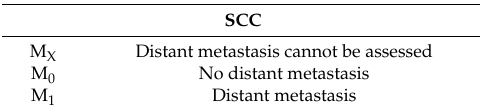
Table 3. American Joint Committee on Cancer Tumor (M) Classification, 8th Edition [65].